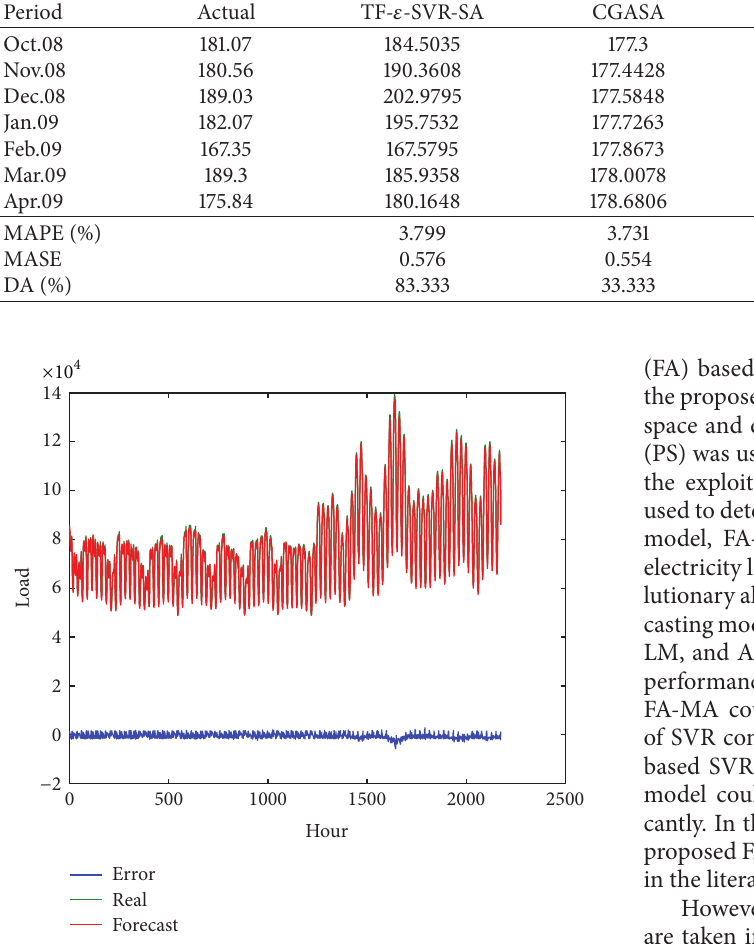
Figure 1: Curves of real values, forecast values, and errors of proposed FA-MA based SVR